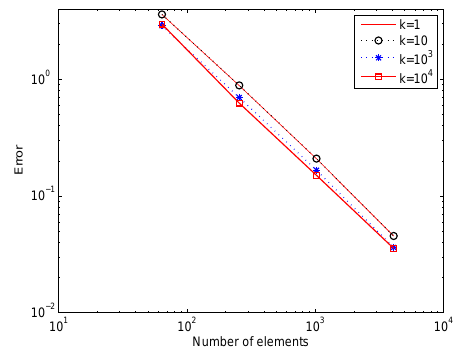
Figure 4. Errors in the energy norm with different k